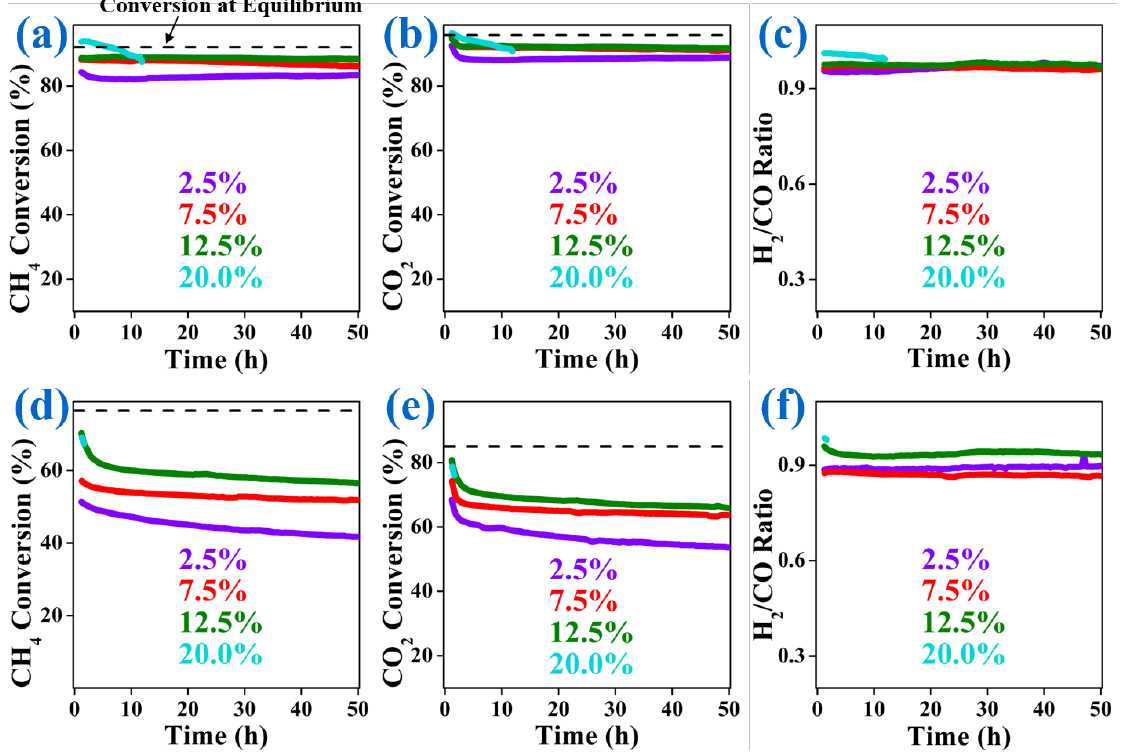
Figure 7. CH 4 conversions ( a ), CO 2 conversions ( b ), and H 2 /CO ratios ( c ) of the Ni@CeO 2 catalysts